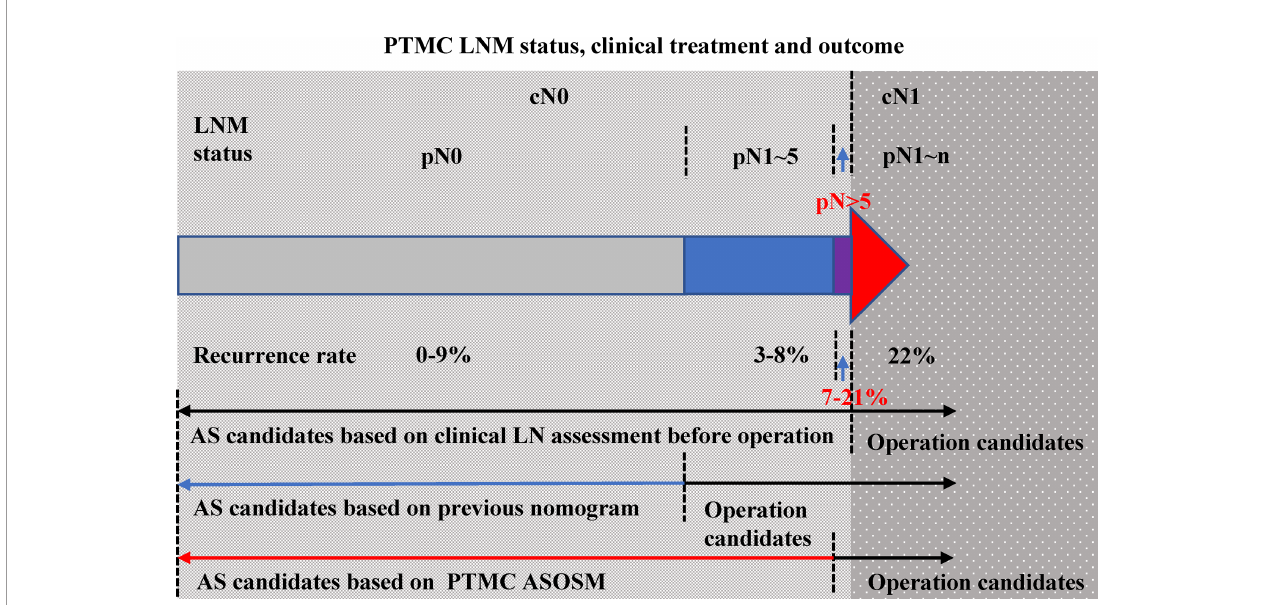
FIGURE 7 | PTMC LNM status, clinical treatment, and outcome.LNM status of PTMC patients can be divided into cN0 and cN1 (color red). The LNM status of cN0 PTMCs included pN0 (color gray), pN1 – 5 (color blue), and pN >5 (color purple). The recurrence rates of these three groups were 0% – 9%, 3% – 8%, and 7% – 21% (the percentage of each part was presented according to reference data). Previous models were used to determine those with PTMC with cN1 and those PTMC without clinically evident nodal. When the ASOS model was established, we draw the ROC curve to get the cut-point value (0.013) of our prediction model which helps to distinguish the patients with high risk of large-number LN metastasis and patients with low risk. Our PTMC ASOS model would help to fi nd those pN >5 cN0 PTMC (prediction risk > 0.013) before operation and help to fi nd those pN <5 cN0 PTMC (prediction risk < 0.013) which would be great candidates of